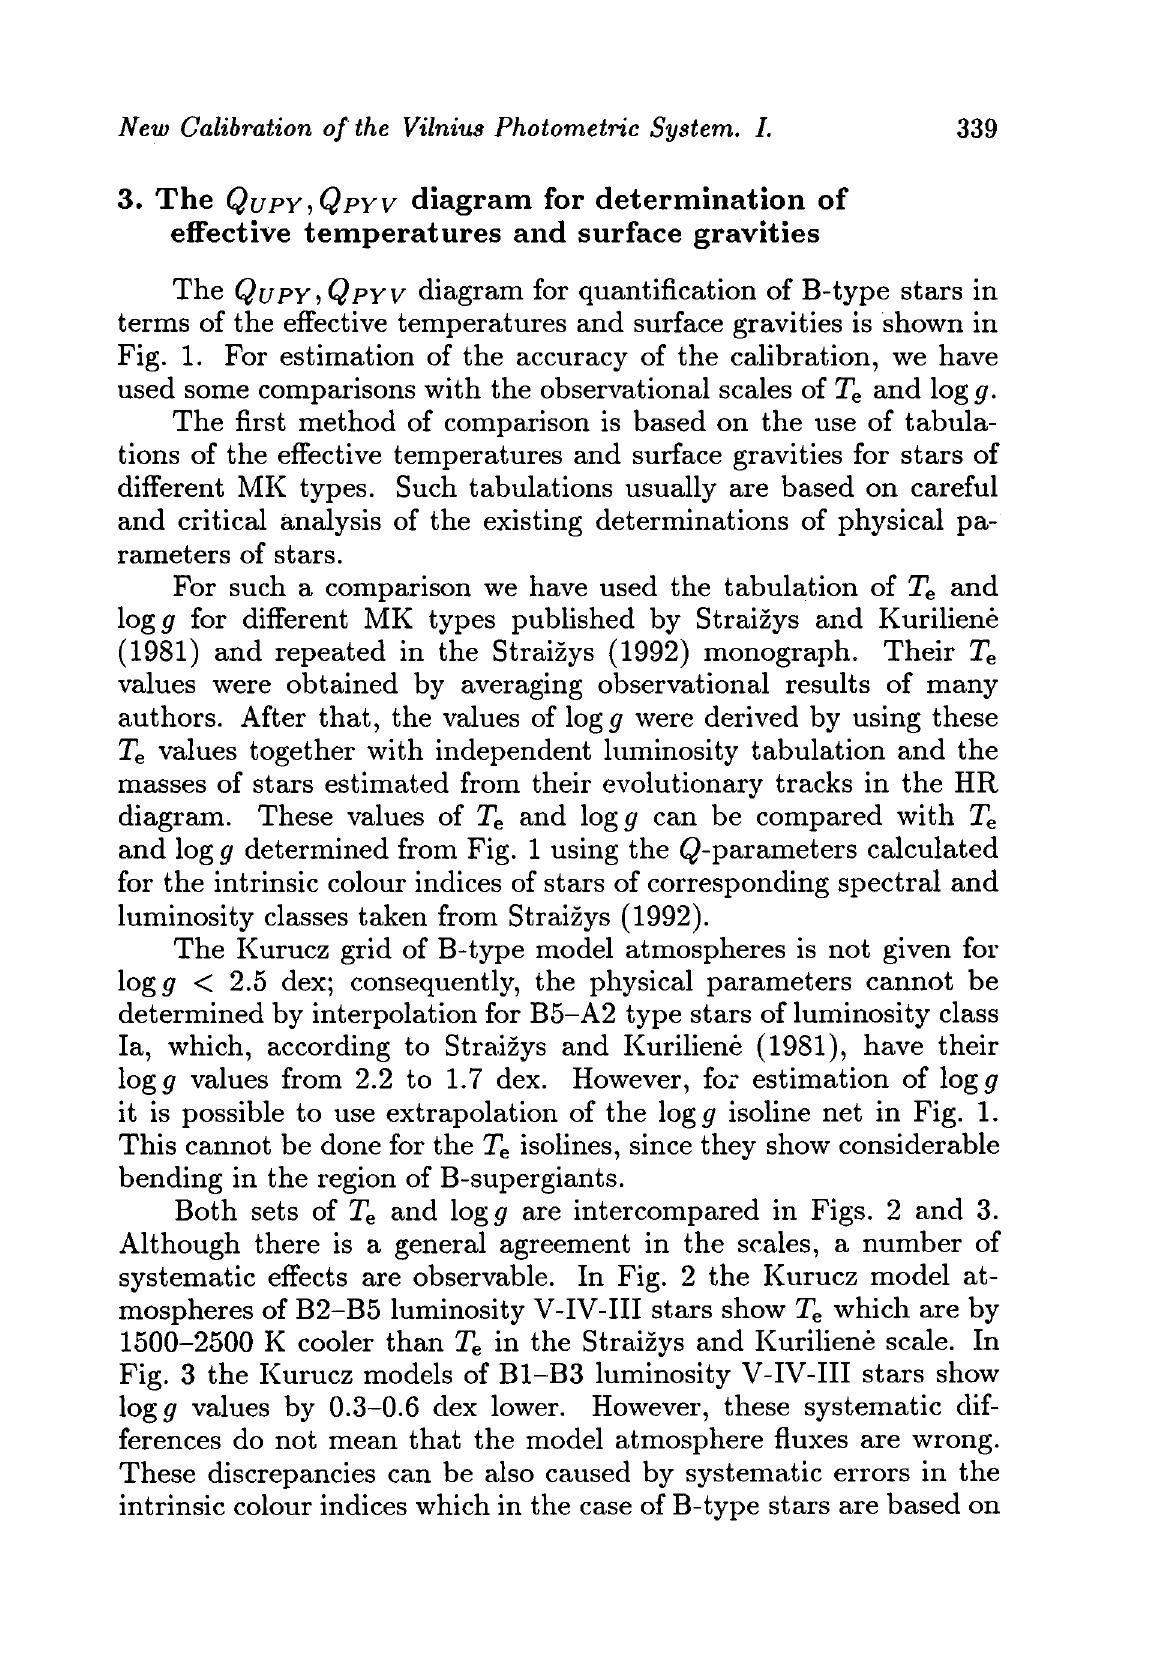
Fig. 3 the Kurucz models of B1-B3 luminosity V-IV-III stars show logg values by 0.3-0.6 dex